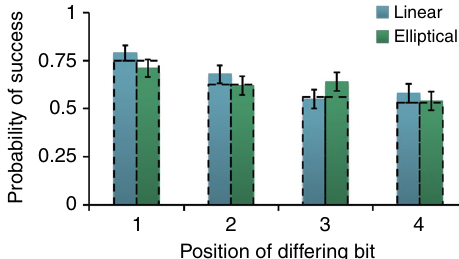
Fig. 4 Success probability for the millionaires problem using the linear (blue or fi rst bar) and elliptical (green or second bar) scheme. We compare different four-bit numbers in binary representation to the number 0101, where each compared number deviates from 0101 in exactly one bit. The expected probability of success (shown in black dotted lines) depends on the position of the differing bit (1 corresponds to the most signi fi cant bit, 4 to the least signi fi cant bit). Error bars show an interval of ±1 standard deviation derived from binomial statistics and are therefore a lower